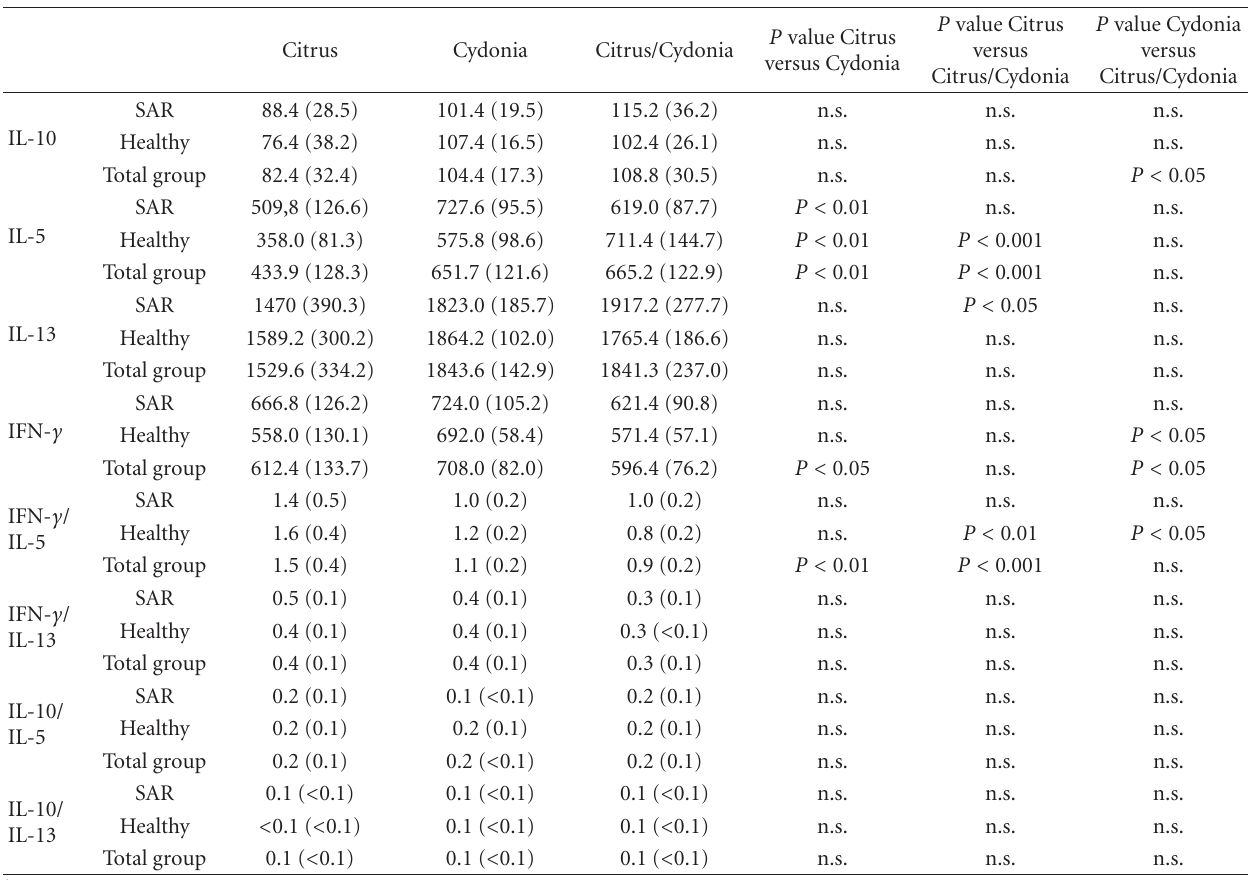
Table 3: Di ff erences in mean scores after seven-day PBMC cultures in the SAR group, healthy group, and total group (grass pollen stimulation minus medium stimulation).